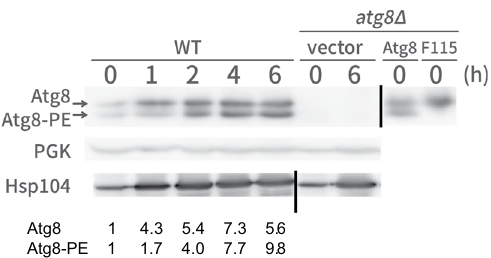
Atg8 Figure 2. Heat-inducible expression of Atg8. Western blotting analysis of wild-type cells and atg8 Δ cells after the indicated times at 40.5 °C. Upper, anti-Atg8 immunoblot, PE-form and non-lipidated forms are indicated by arrows. A blot of atg8 Δ cells expressing Atg8 and non-lipidated form of Atg8-F115 were shown to indicate the positions of Atg8 and Atg8-PE. Middle, anti-PGK1 immunoblot, a control for protein loading and lower, anti- Hsp104 immunoblot, a control for heat shock induction. Lines indicate results are from different